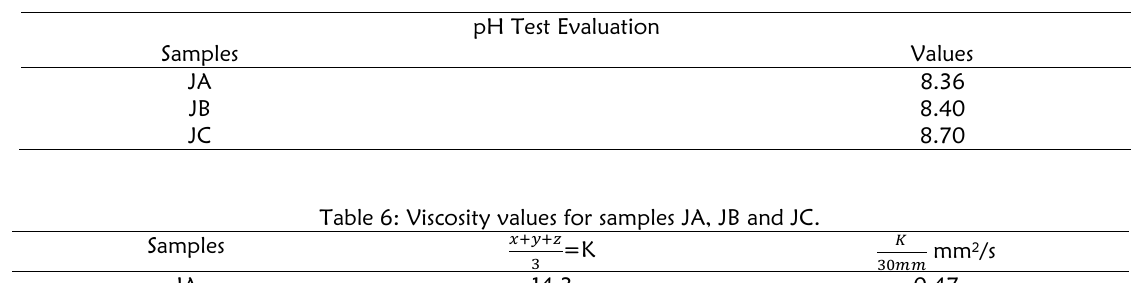
Table 5: pH values for samples JA, JB and JC